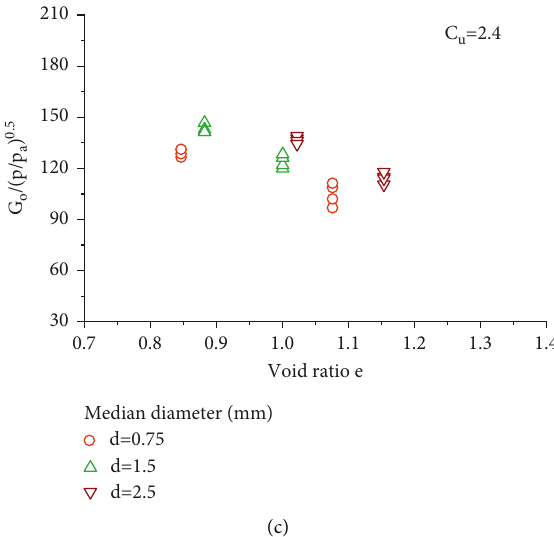
Figure 12: G ( p / p ) n and void ratio for calcareous sand at different confining pressure. (a) Cu � 1.2, (b) Cu � 1.8, and (c) Cu � 2.4. o / a